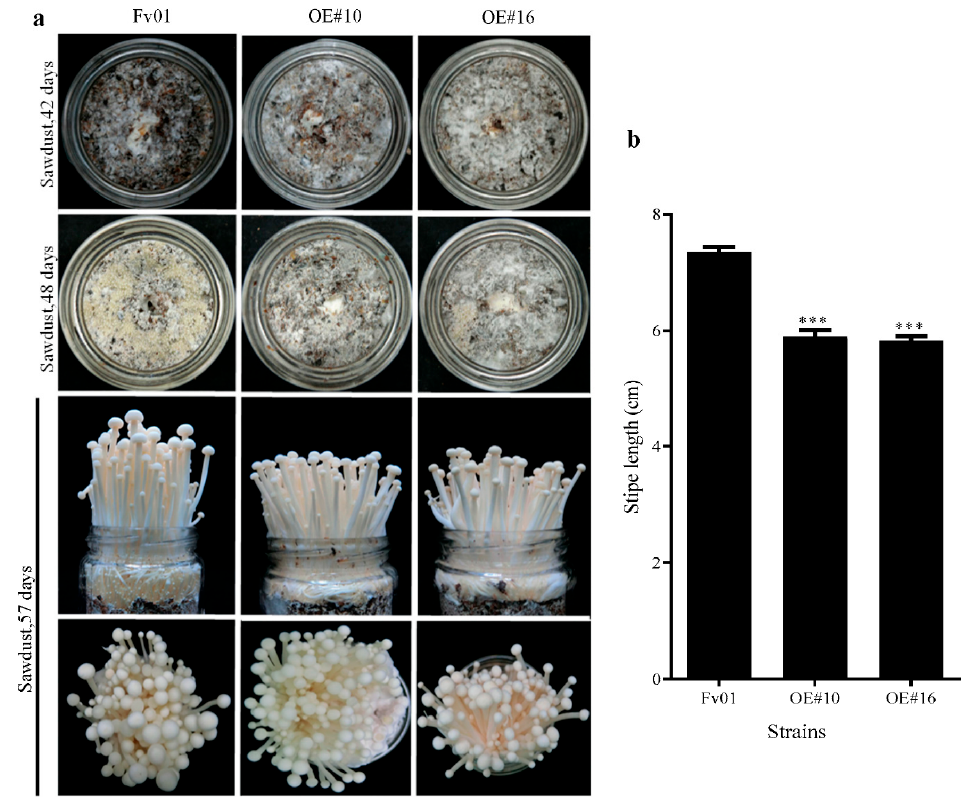
Figure 6. The fruiting body phenotype of transformants. ( a ) Fruiting phenotype of FfGS6 overex- pression transformants of F. filiformis and the control group. ( b ) Stipe length measurement 9 days after primordium formation. Asterisks represent significant differences versus Fv01 ( t -test, n = 20; ***, p < 0.001).